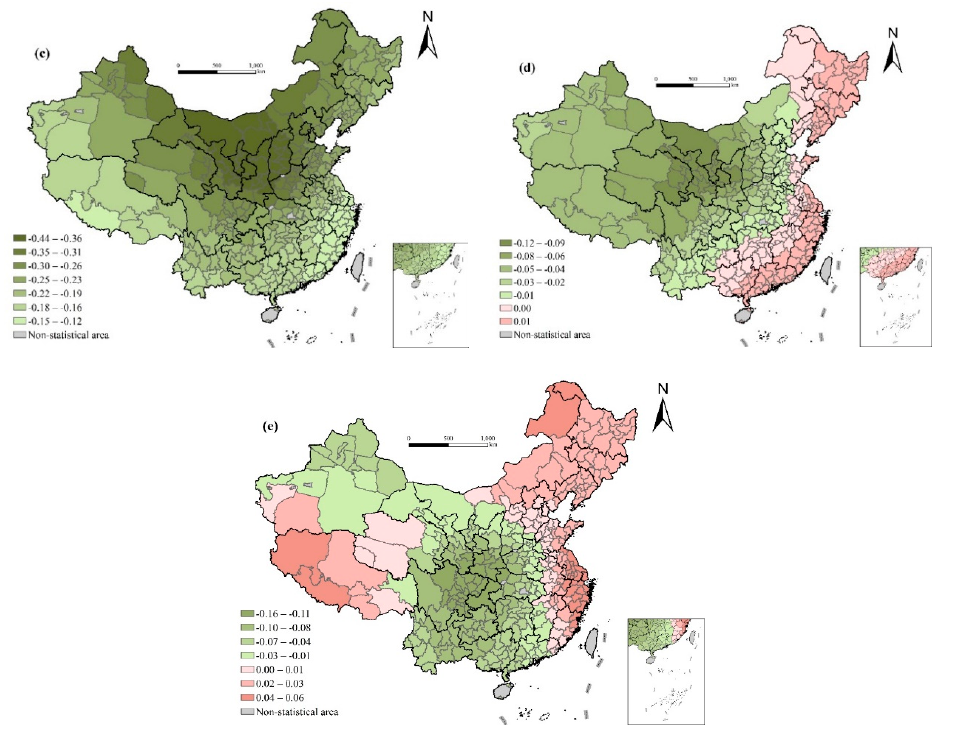
Figure 6. Spatial variation of regression outputs from the GWR model: ( a ) aging rate; ( b ) average years of education; ( c ) average household size; ( d ) sex ratio; and ( e ) the proportion of migrants.